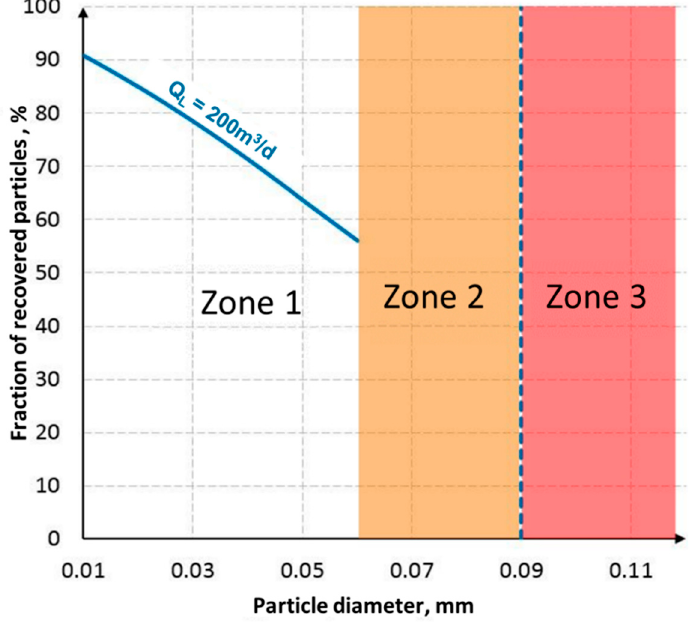
Figure 6. Quality of recovery of solid particles by fractions at 200 m 3 /d.